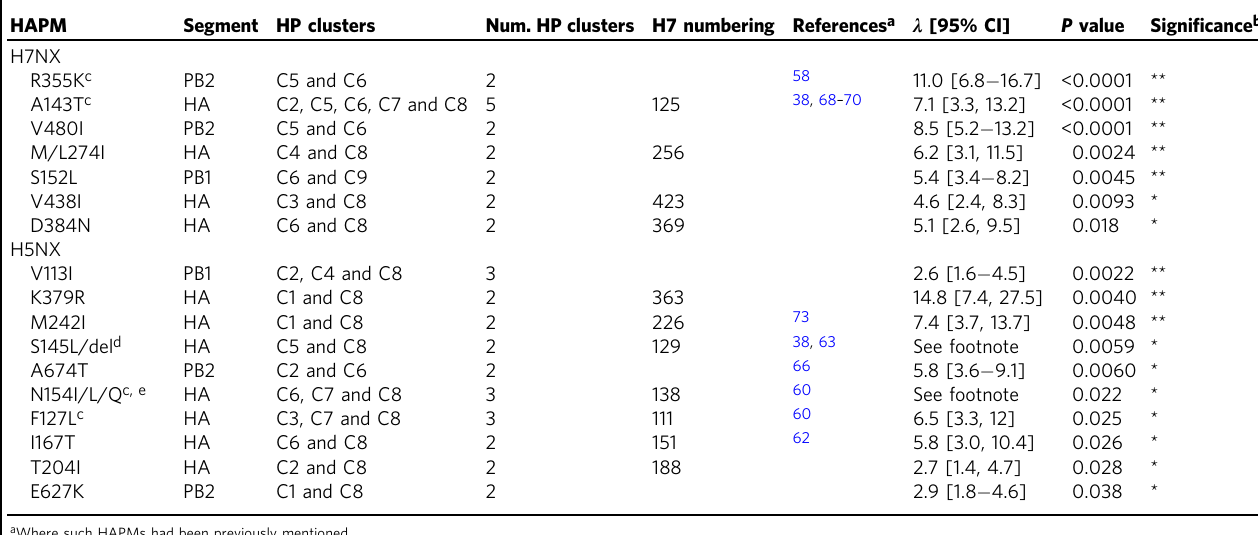
Table 1 HAPMs signi fi cantly associated with the HP phenotype of H5 and H7 virus subtypes.